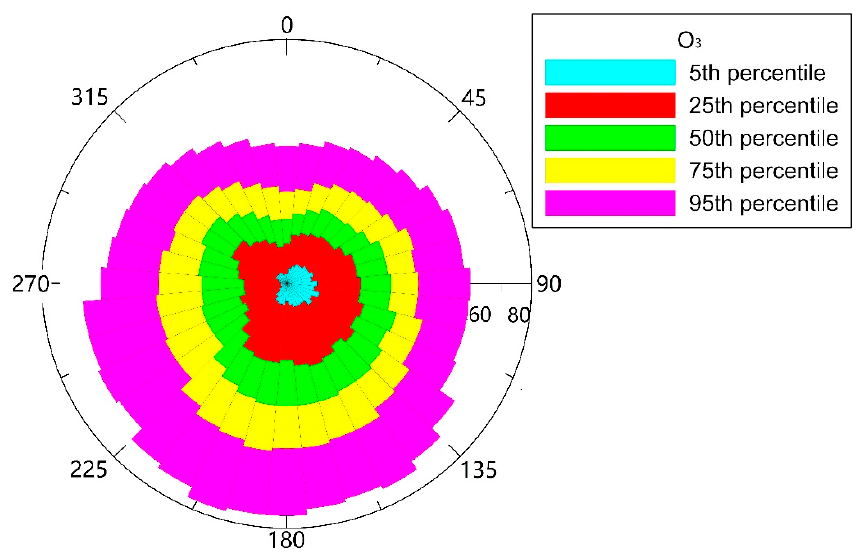
Figure 2. Ozone pollution rose in Windsor during the smog season of 1996–2015.